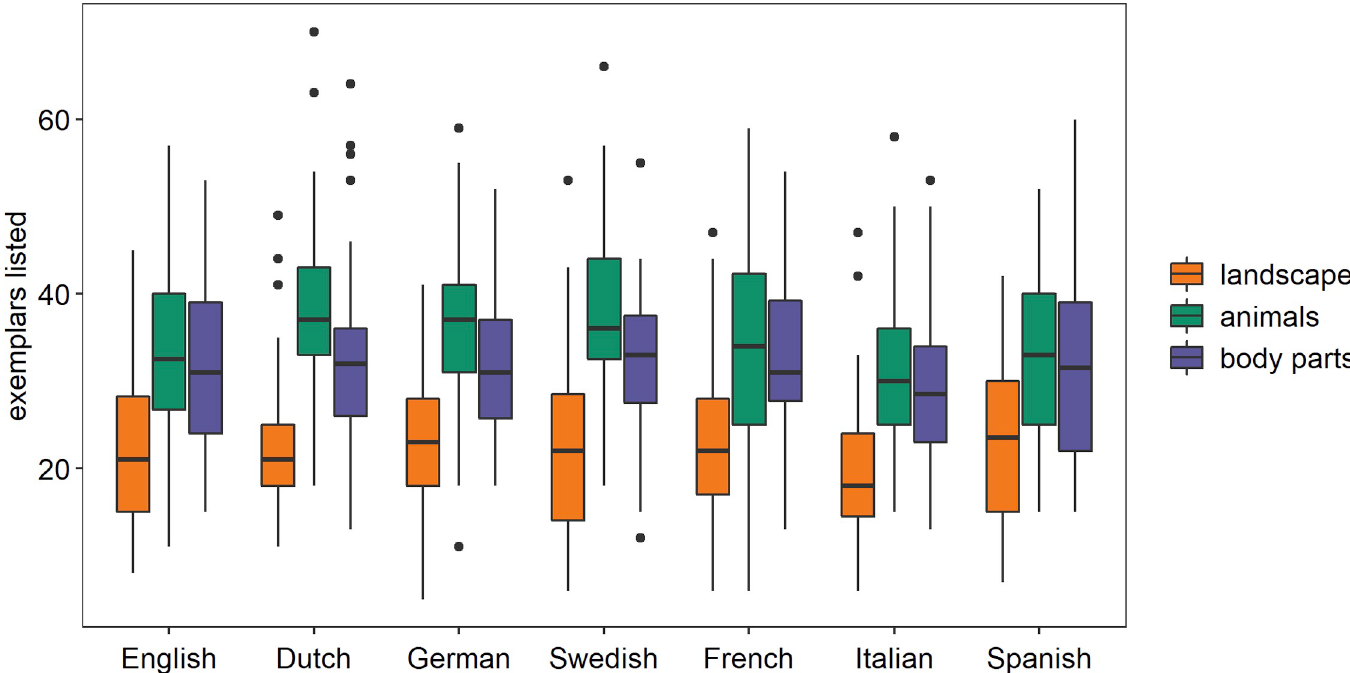
Fig 1. Number of exemplars listed for “landscape”, “animals” and “body parts” by speakers of seven languages. “Landscape” elicited the fewest exemplars in all languages.